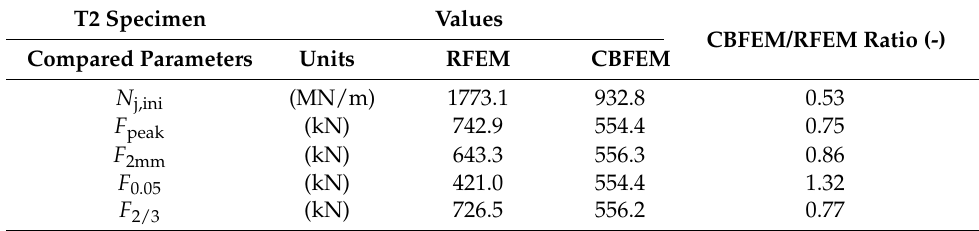
Table 5. Comparison of CBFEM and RFEM models for specimen T2. T2